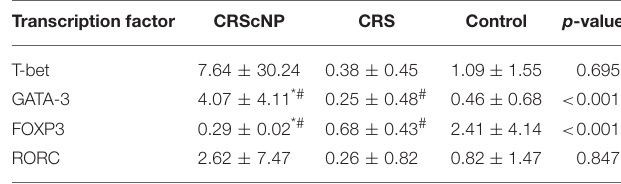
TABLE 4 | Transcription factor analysis of rhinosinusitis